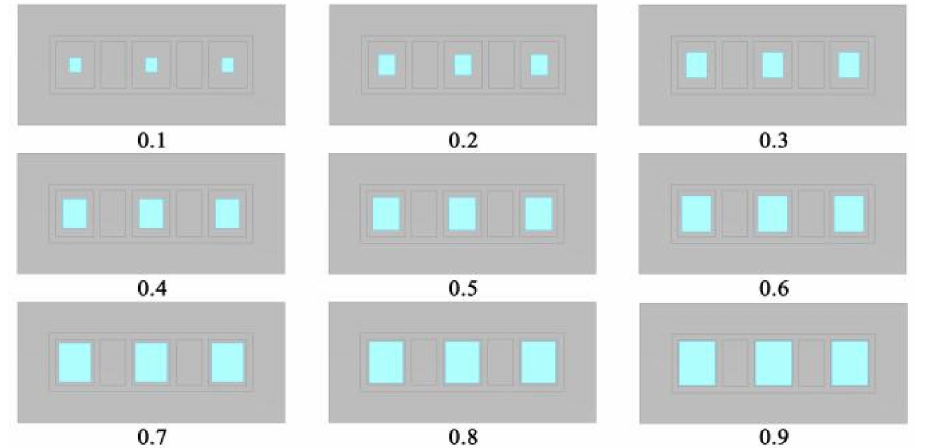
Figure 11. Skylight roof ratio diagrams.